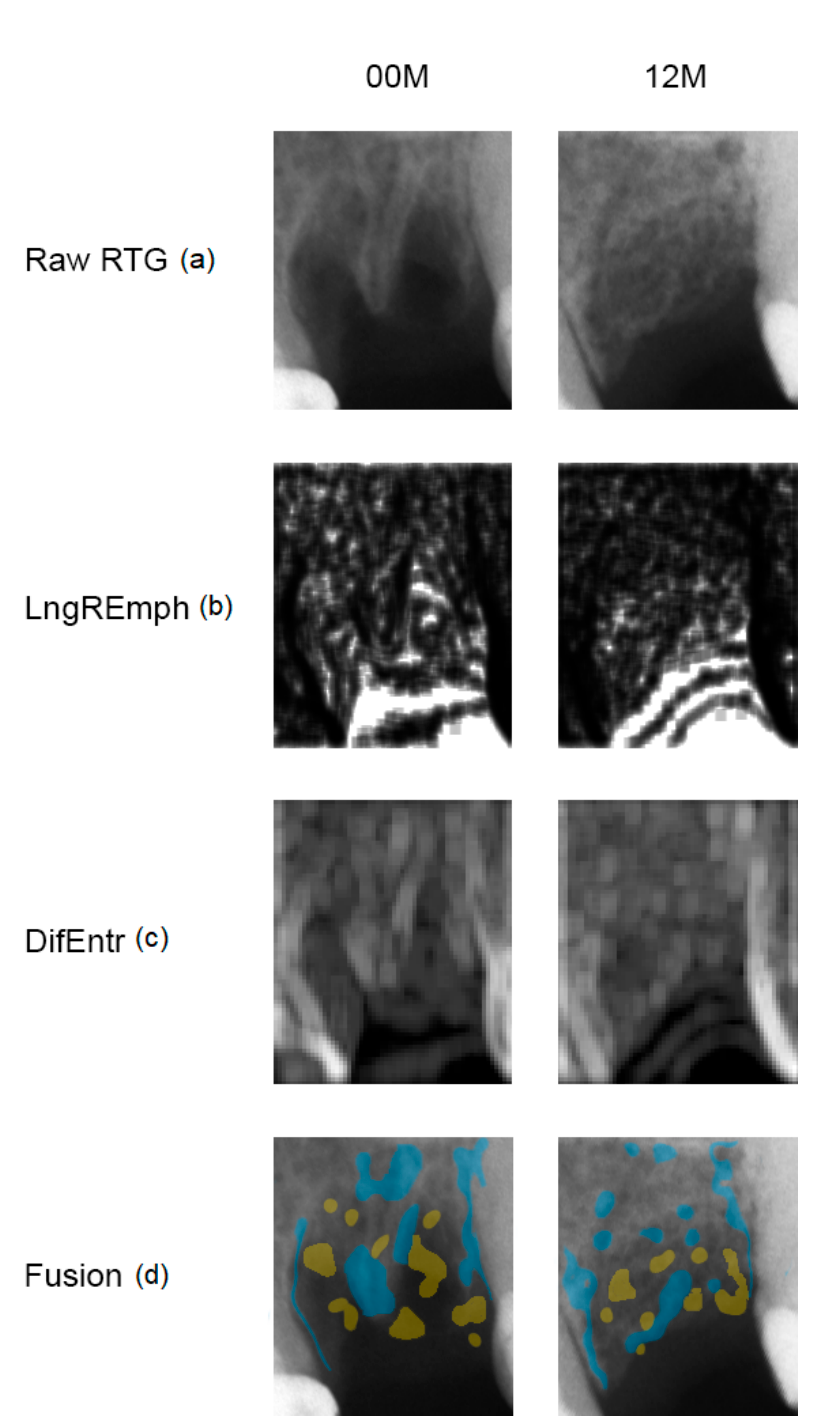
Figure 1. Collagen-guided alveolar crest augmentation. Raw RTG ( a ): intraoral radiograph immediately after collagen implantation into the alveolar (00 M) and at a 12-month follow-up (12 M). LngREmph ( b ): a map of the occurrence of long chains of pixels of similar optical density; brighter fields indicate more of such occurrences in the X-ray image. DifEntr ( c ): map of regions with chaotically arranged small elements recorded in the X-ray; brighter places indicate a more chaotic microstructure. Fusion ( d ): the application of places on the raw X-ray which represent the largest occurrence of long pixel chains (yellow = high LngREmph) in the alveolar crest and the most chaotic places (blue = high DifEntr). Please note that yellow areas do not coincide with blue areas. This is due to the detection of the different structurally different alveolar regions, i.e., LngREmph = radiolucent regions = soft tissue, while DifEntr = trabecular regions = bone.